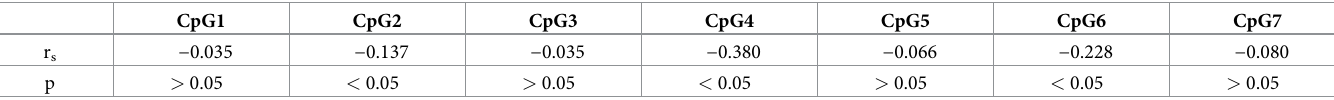
Table 4. Spearman correlation analysis for individual CpGs of H19 methylation levels and urinary